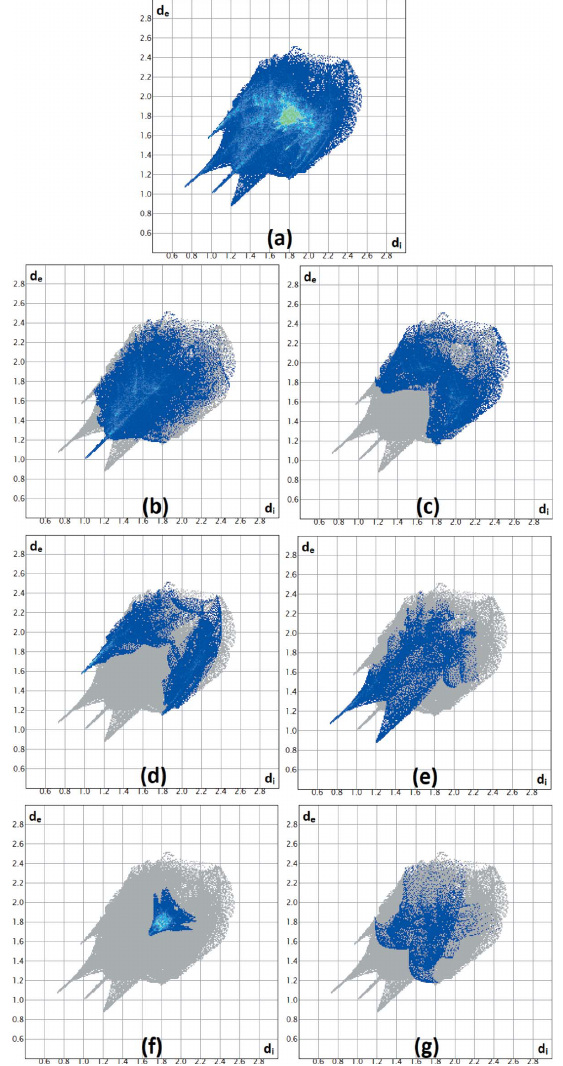
Figure 5 Fingerprint plots of the interactions involving the organic cation. ( a ) All contributions and decomposed into the main contributions: ( b ) H (cid:2)(cid:2)(cid:2) H, ( c ) H (cid:2)(cid:2)(cid:2) C/C (cid:2)(cid:2)(cid:2) H, ( d ) H (cid:2)(cid:2)(cid:2) Cl/Cl (cid:2)(cid:2)(cid:2) H, ( e ) H (cid:2)(cid:2)(cid:2) O/O (cid:2)(cid:2)(cid:2) H, ( f ) C (cid:2)(cid:2)(cid:2) C and ( g ) N (cid:2)(cid:2)(cid:2) H/H (cid:2)(cid:2)(cid:2) N interactions